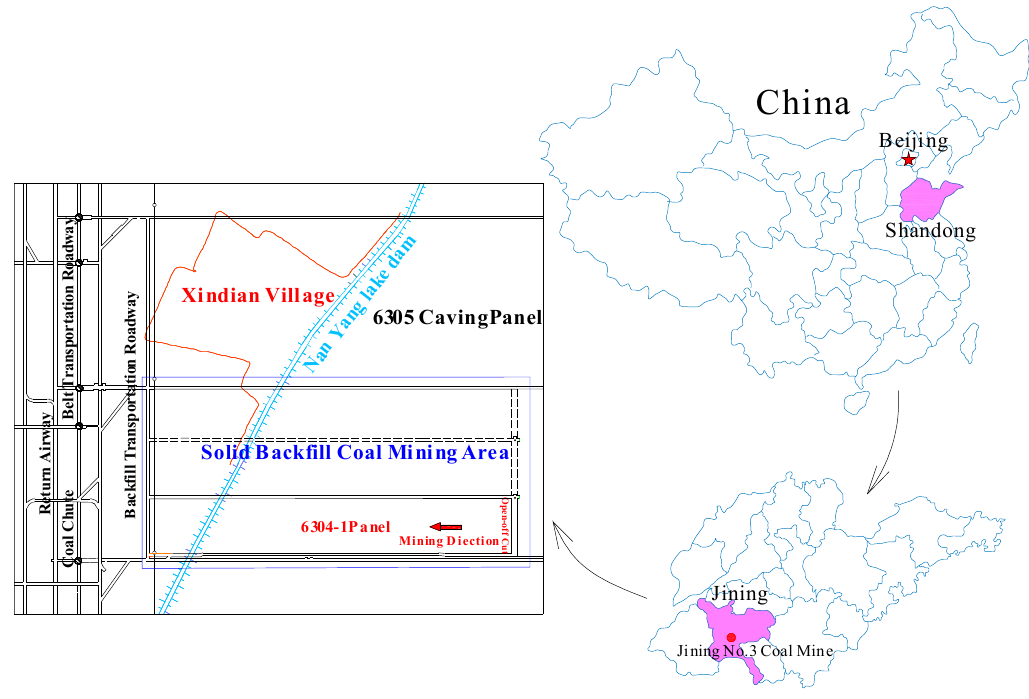
Figure 3. Position of the coal mine and layout of the 6304 working panel. Table 1. The details of roofs and floors in the No. 3 coal seam.